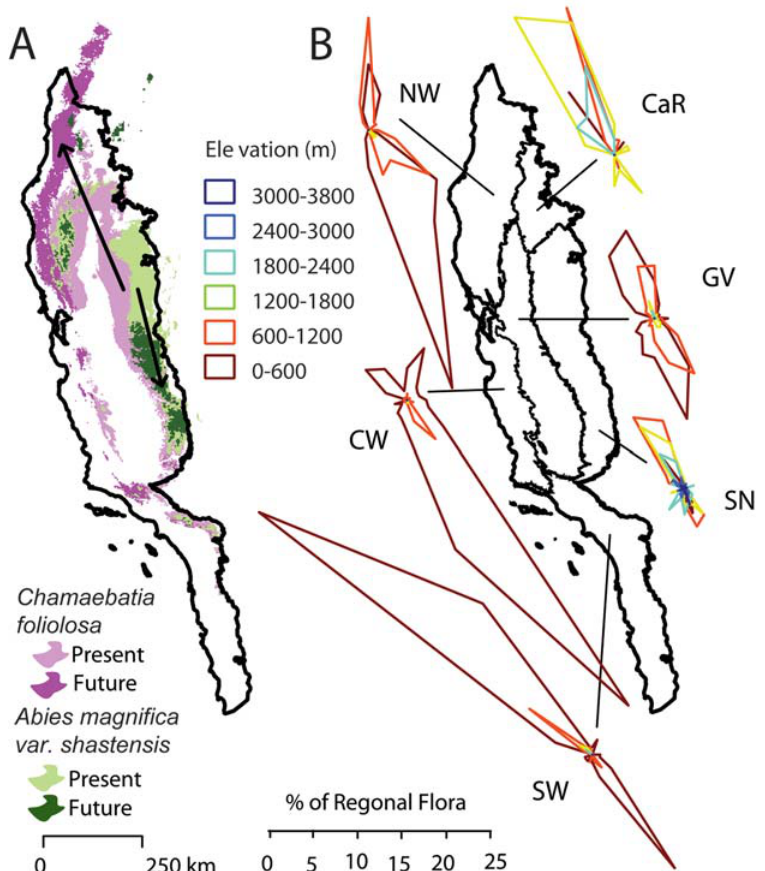
Figure 3. Movement of species geographic centroids based on HadCM3 simulations using the A1FI emission scenario 80 years in the future and assuming species can move. (A) Two representative species that have adjacent present ranges (lighter colors) and are projected to move in opposing directions (arrows and darker colors). (B) Projected centroid movements for all species. Individual polar plots group species by the floristic region in which their centroid originates. Within each plot, species are grouped by the elevation in which their centroids originate. The magnitude of the directions represents the percentage of the regional flora moving in each direction.